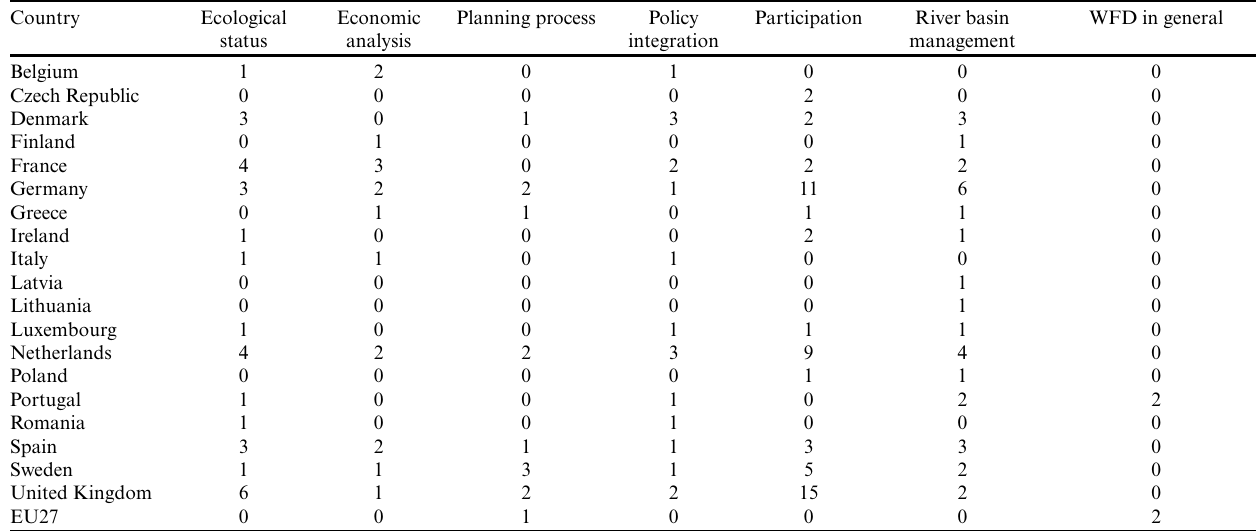
Table 3 . Number of studies per country and WFD theme. Country Ecological